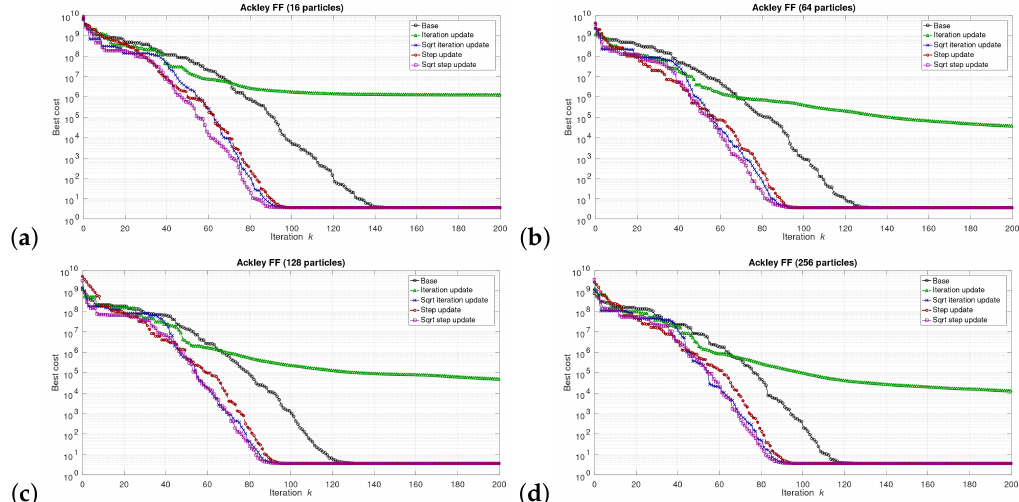
Figure 3. Selected results for Ackley FF for ( a ) 16, ( b ) 64, ( c ) 128, and ( d ) 256